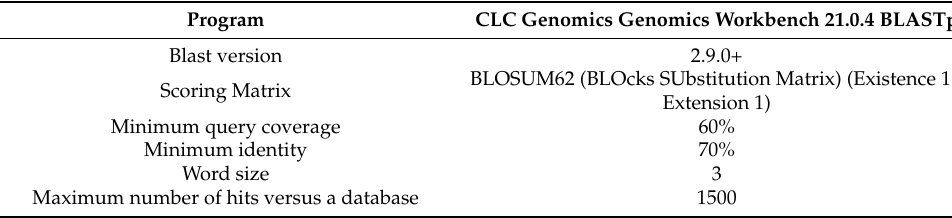
Table 1. BLAST (Basic Local Alignment Search Tool) parameters for intrinsic occurrence